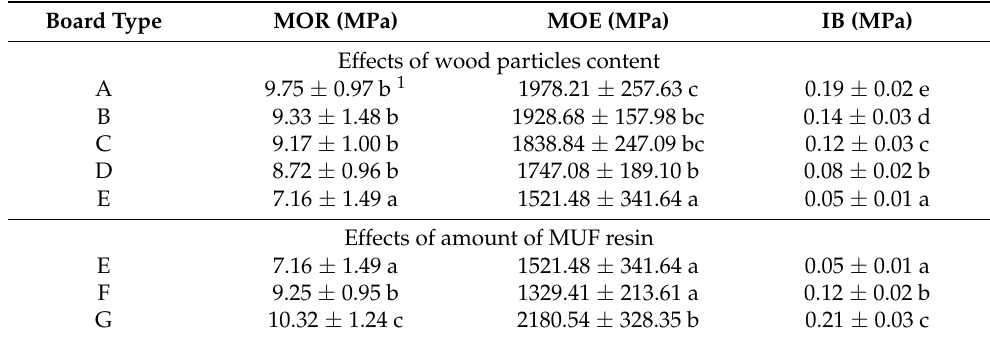
Table 4. Mechanical properties of particleboards.